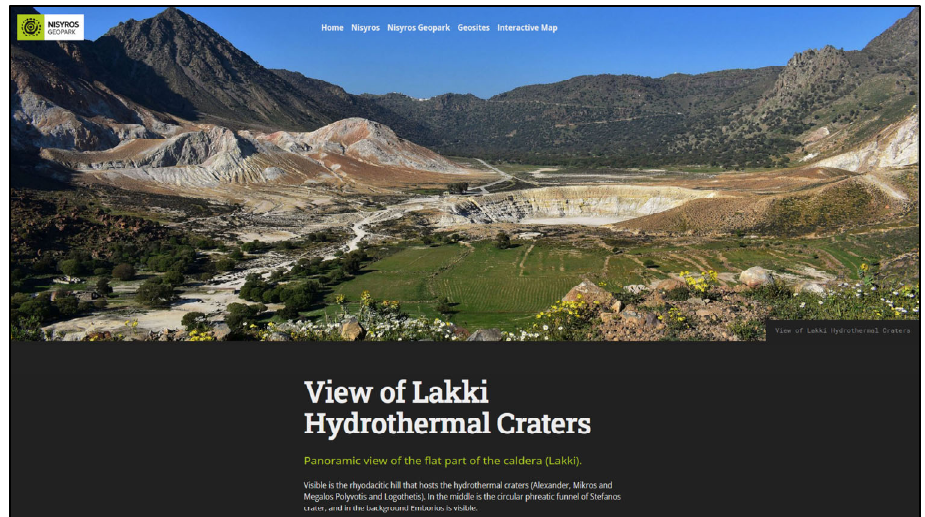
Figure 8. Example of the user-friendly interface of the official Nisyros Geopark website. High resolution, widescreen images accompanied by short, explanatory text regarding a panoramic geosite toward Stefanos Crater and its surroundings.